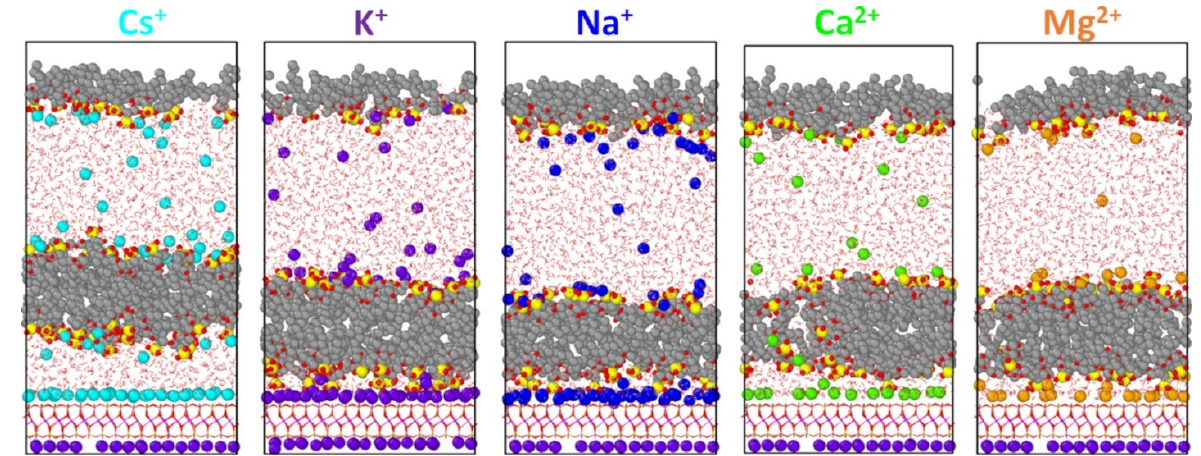
Figure 4. Snapshots from MD simulations of 48 AOT systems at 300 K showing the formation of bilayers at the mica–water interface. Atom rendering and coloring is the same as Figures 1 and 2. Atomic density profiles allow details of AOT layer thickness and surface coverages